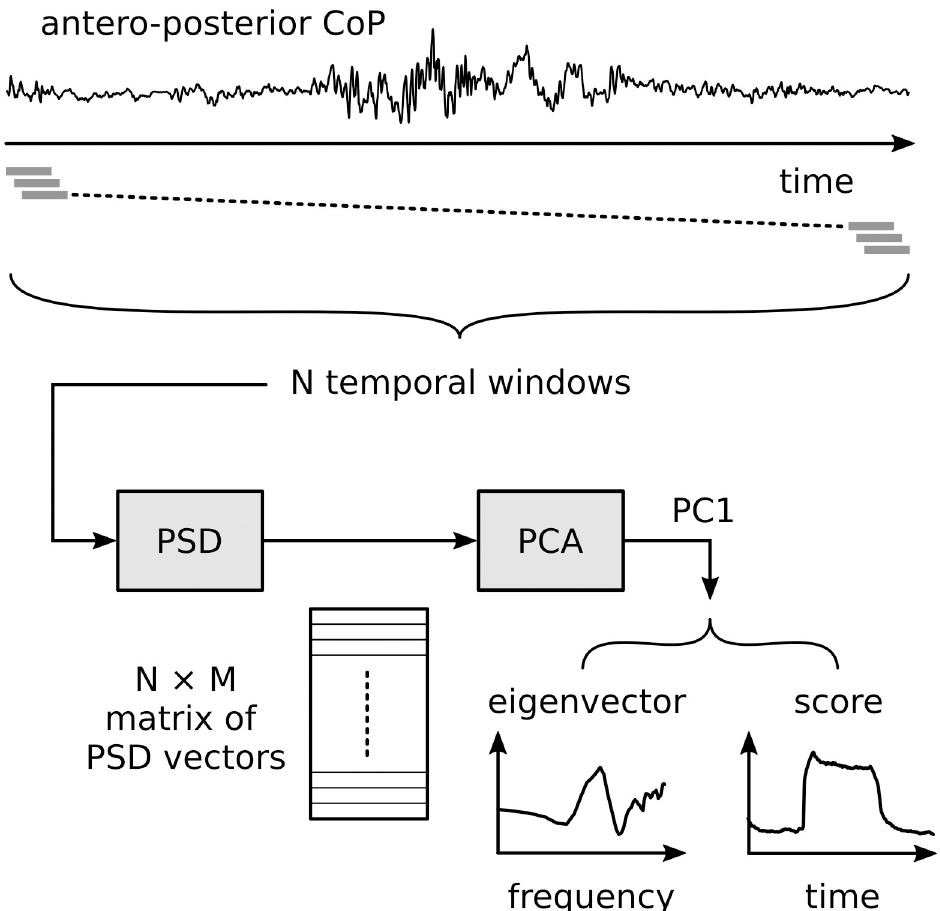
Fig 2. Depiction of the procedure for processing the posturographic signal. An example of the antero-posterior CoP signal covering 180 s is shown on the top. The sliding windows of 10 s are represented as gray rectangles just below the signals. The PSD analysis is done for each one of the N windows. The PSD vectors for the windows, which are vectors containing the M spectral components, are organized into an N × M matrix. This matrix is then fed to the PCA procedure. The first component PC1 is extracted and its eigenvector (spectral profile) and score (temporal profile) are used in the further analyses.